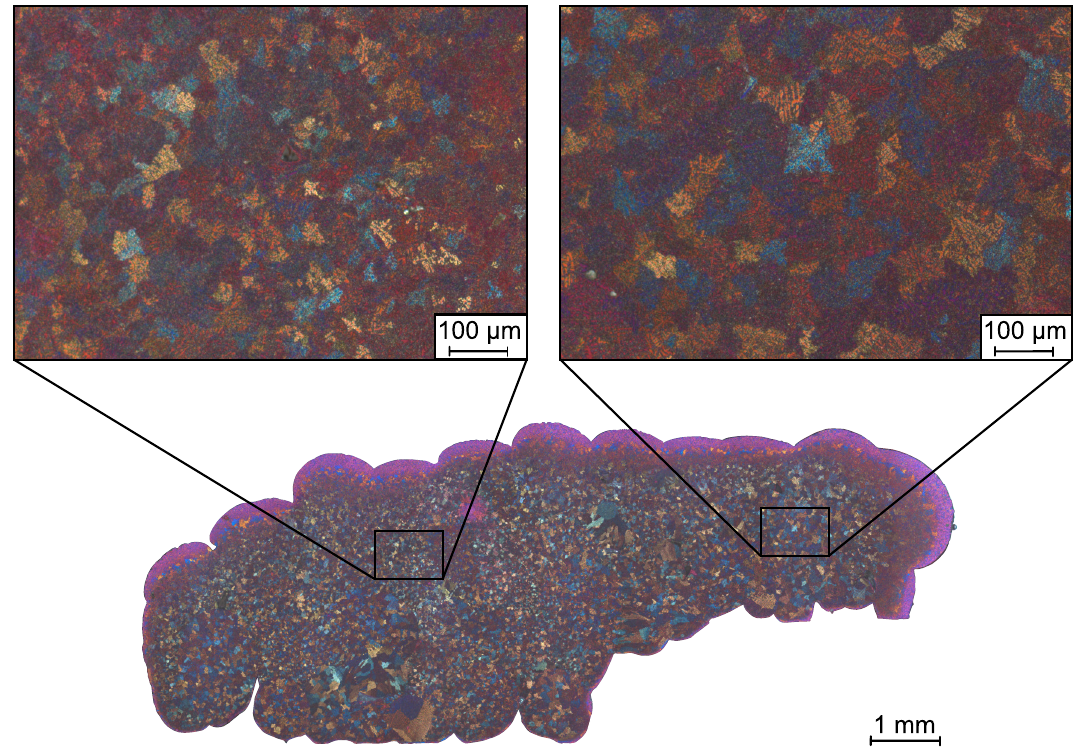
Figure 9. Cross-sectional area of UL-sample etched with two percent aqueous sodium hydroxide solution and alkaline potassium permanganate solution according to Weck et al. [22]. The images above the cross-sectional area show the detailed views of the material microstructure of the sample area above the aluminum (left side) and above the salt support structure (right side). A coarser dendrite structure can be seen in the area above the salt support